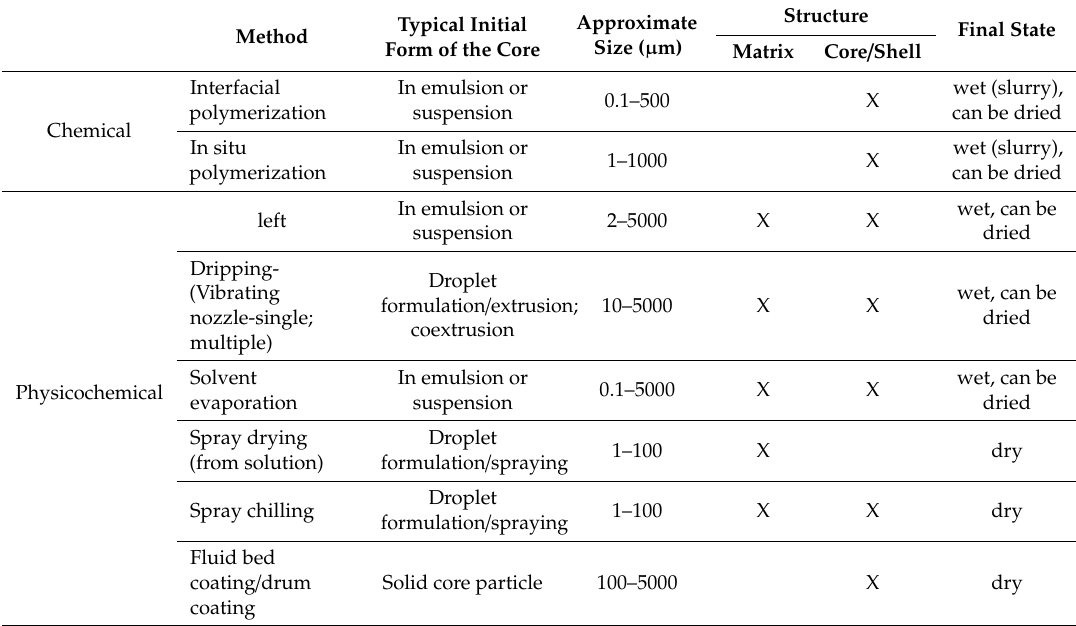
Figure 8. Calcium alginate microparticles: ( a ) initial (prepared using a Büchi B-390 Microencapsulator), ( b ) freeze-dried, and ( c ) reconstituted in a pH 6.8 phosphate buffer (60 min). Table 7. Classification of main procedures to prepare microparticles, spheres, and microcapsules.